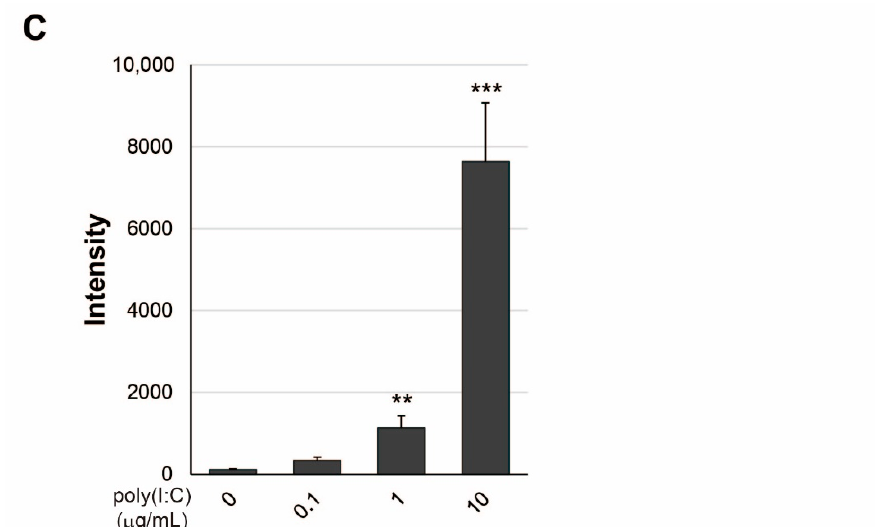
Figure 2. N-terminal fragments of SEAP SP in exosomes released from HEK-Blue hTLR3 cells. ( A ) The peptide solution extracted from exosomes of HEK-Blue hTLR3 cells in the presence of poly(I:C) at 0–10 μ g/mL for three days was analyzed by MALDI-TOF MS. ( B ) MS/MS analysis of peaks at m / z 1277 +/ − 6 was performed. ( C ) The peak intensity at 1277 was measured by MALDI-TOF MS. ** p < 0.01, *** p < 0.001 vs. the absence of poly(I:C).